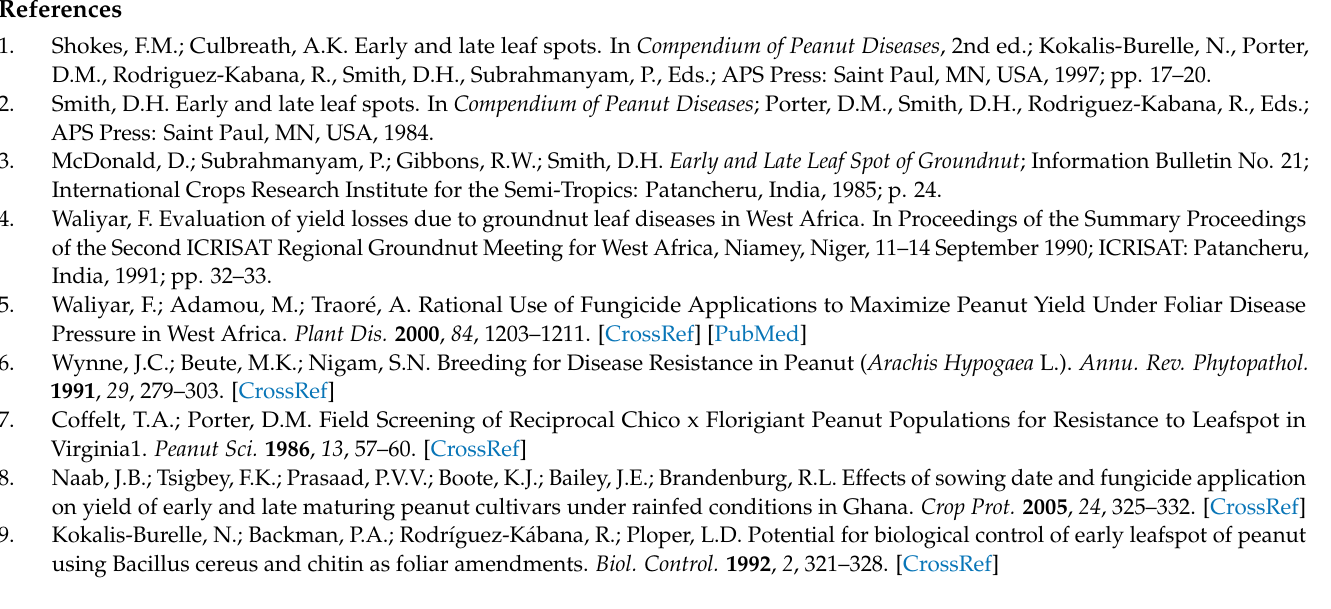
Table S2, Summary of selections; Supplementary Table S3, CalcIP6.c—computer program to interpo- late percentages of diseased plants over time, and estimate days to 50% infected